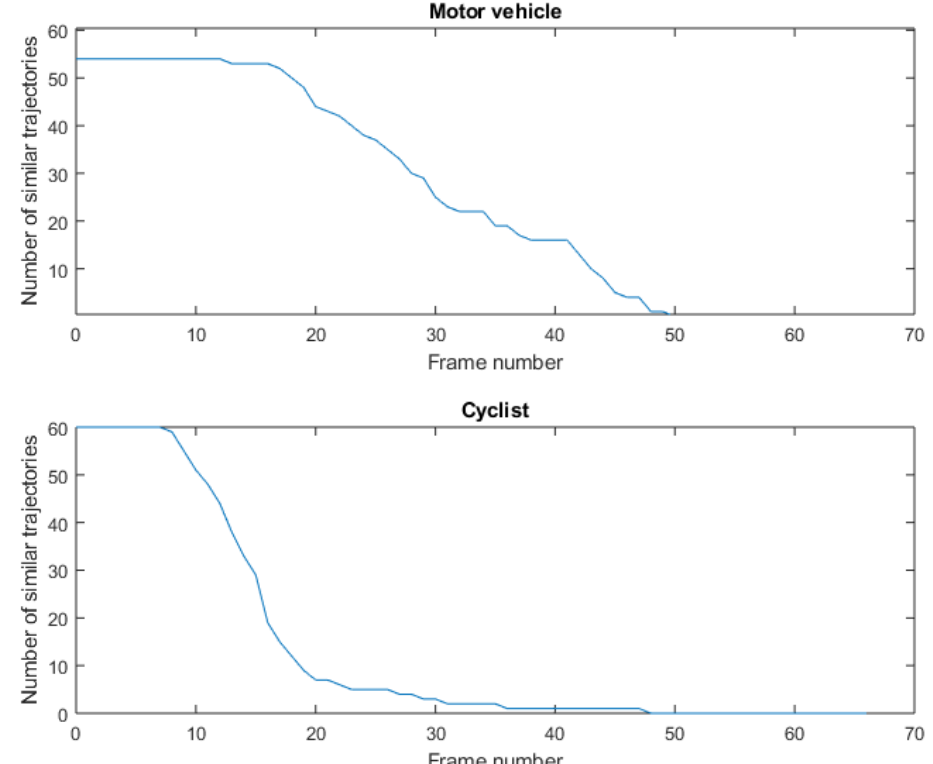
Figure 4 The number of similar trajectories for each time step between two interacting trajectories and a set of unhindered trajectories